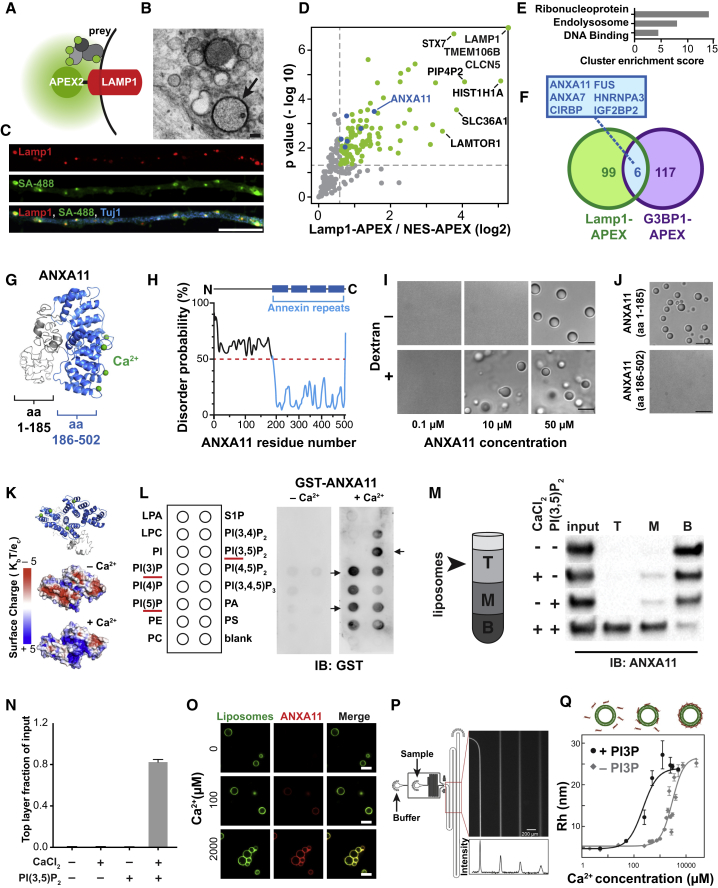
Identification of ANXA11 as a Potential Mediator of RNA Granule-Lysosome Associations(A–G) Proximity labeling proteomic screen for lysosomal interacting proteins in i3Neurons.(A) Schematic of LAMP1-APEX2 bait.(B) Electron microscopy image of DAB precipitate generated by LAMP1-APEX2 (dark contrast, arrow) surrounding lysosomes in i3Neurons. Scale bar: 100 nm.(C) Confocal immunofluorescence image of LAMP1-APEX2 biotinylated prey (streptavidin-488 staining) surrounding LAMP1-positive lysosomes in i3Neuron axons (Tuj1). Scale bar: 10 μm.(D) Plot showing statistically significant LAMP1-APEX2 enriched prey proteins from proximity-labeling proteomics in i3Neurons. n = 4, p values corrected for multiple comparisons.(E) Functional Annotation Clustering of DAVID Gene Ontology terms of Lamp1-APEX enriched prey.(F) Venn diagram of LAMP1-APEX2 hits versus G3BP1-APEX2 stress-granule hits (Markmiller et al. 2018). Overlapping hits are also represented as blue dots in (D).(G) Predicted structural analysis of ANXA11 revealed four C-terminal calcium-binding annexin repeats (blue), and a disordered N-terminal region.(H–J) Recombinant ANXA11 undergoes liquid-liquid phase separation in vitro.(H) PrDOS analysis of ANXA11 predicted a high likelihood of disorder of aa 1-185.(I) Full-length ANXA11 formed spherical, fusing liquid droplets at concentrations above 50μM (upper panel). Phase separation of ANXA11 was facilitated by 10% dextran, with phase separation occurring at lower ANXA11 concentrations (≥ 10μM). Scale bar: 5 μm. See also Figure S2A.(J) The disordered N-terminus (aa 1-185, upper panel) of ANXA11 but not C-terminus (aa 186-502, lower panel) underwent liquid-liquid phase separation. Scale bar: 5 μm.(K–Q) Recombinant ANXA11 interacts with negatively charged lysosome-associated phospholipids.(K) Surface maps of predicted ANXA11 structure +/– Ca2+ showing increased positive surface charge (blue) in the presence of Ca2+. Top panel shows orientation of ANXA11 and location of Ca2+ ions (green).(L) Protein lipid overlay assay of recombinant ANXA11-GST protein with membrane lipids. Recombinant ANXA11-GST protein was incubated with a membrane lipid strip +/– Ca2+, followed by anti-GST immunoblotting. Arrowheads indicate enriched lipid binding. Red line highlighted the correlated phospholipid species.(M) Liposome flotation assay of recombinant ANXA11 with liposomes containing PI(3,5)P2 in the absence or presence of Ca2+. Liposomes with associated proteins floated to the top layer following ultra-centrifugation (schematic). ANXA11 in the top (T), middle (M) and bottom (B) fractions was detected via anti-ANXA11 western blot.(N) Quantification ANXA11 enrichment in the top liposome fraction in Figure 2M. n = 3, error bars = SEM.(O) Microscopy analysis of calcium-dependent recruitment of recombinant ANXA11 protein to fluorescent PI3P-containing liposomes. Representative images showed ANXA11 binding to PI3P-containing liposomes at the indicated calcium concentrations. Scale bar, 5μm.(P) Microfluidic device design for diffusional sizing assay of calcium-dependent ANXA11 binding to liposomes. Inset indicates detection area. The fluorescence intensity along the channel indicates different diffusion times of ANXA11. Scale bar, 200 μm.(Q) Microfluidic diffusional sizing assay to assess changes in molecular radius of ANXA11 upon Ca2+-dependent binding to liposomes (top panel). Bottom panel: Quantification of hydrodynamic radius of ANXA11 when binding to liposomes with (dots) and without (diamonds) PI3P versus Ca2+ concentration. Data were fitted with a Hill binding model.